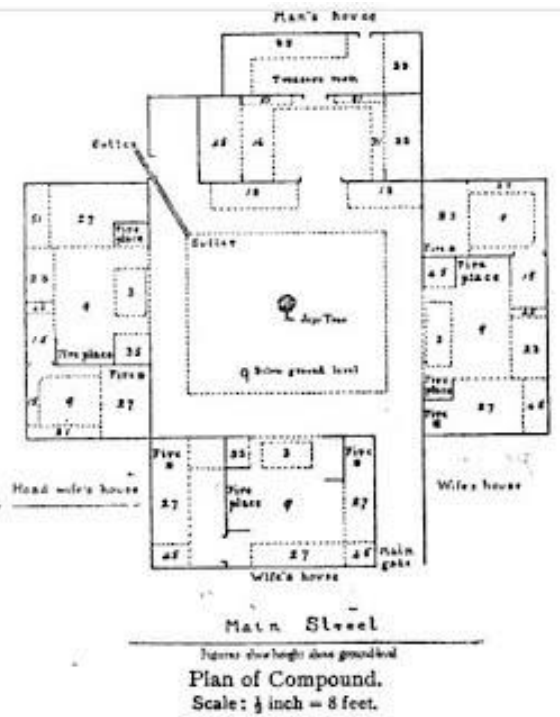
Figure 13iii. Plan of a Family Compound with courtyard in the centre and Building Units Surrounding it. Source:www.google.com .